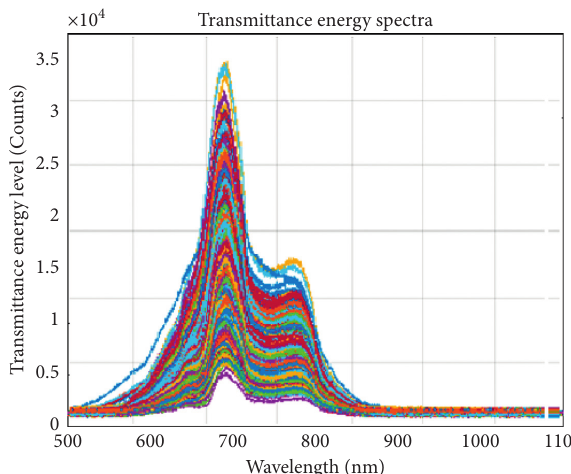
Figure 2: Transmittance energy spectra curves obtained from potato tubers by using VIS/NIR